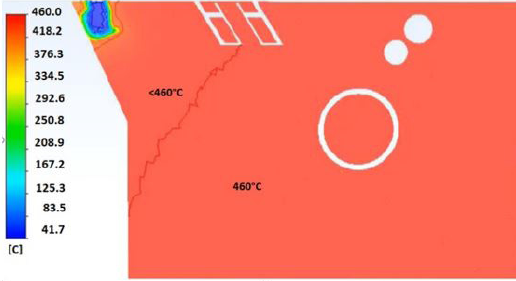
Figure 11. Temperature distribution with the solid ingot at 40° C 25% inserted in the zinc bath.